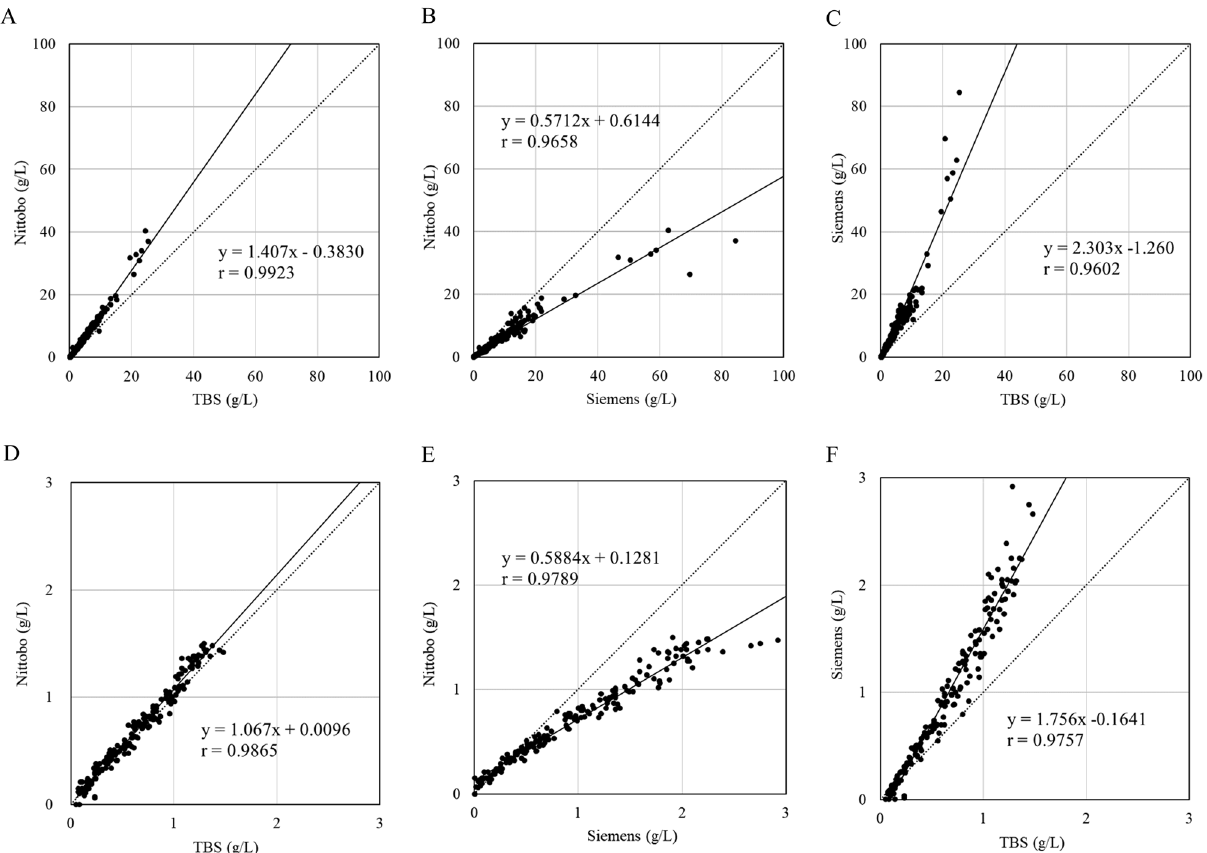
Figure 1. Correlations between the three reagents. Correlation diagrams for the three reagents using all patient data are shown in panels ( A ), ( B ) and ( C ). Panels ( D ), ( E ) and ( F ) show the data of patients with Nittobo values less than 1.5 g/L. Regression lines were calculated using major-axis linear regression and drawn as the solid line together with the small dotted line of equality (Y =